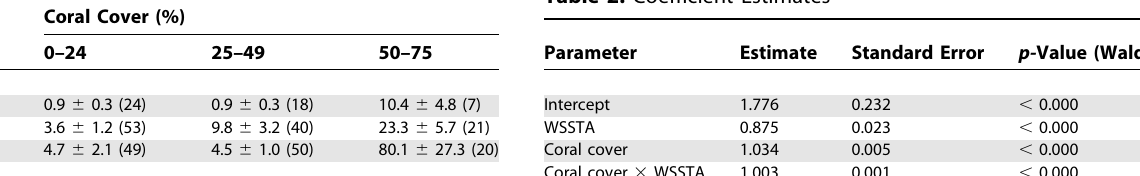
Table 2. Coefficient